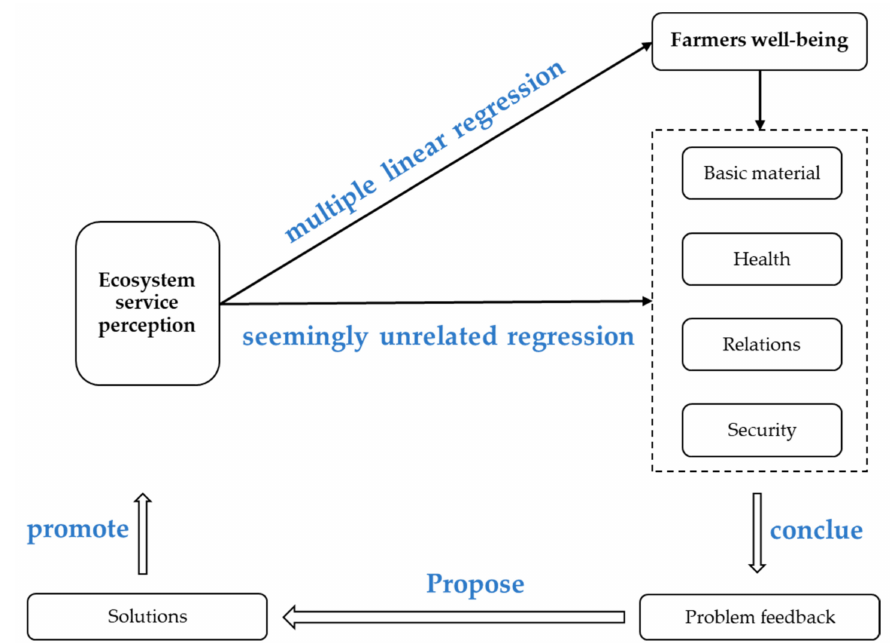
Figure 1. Study the framework